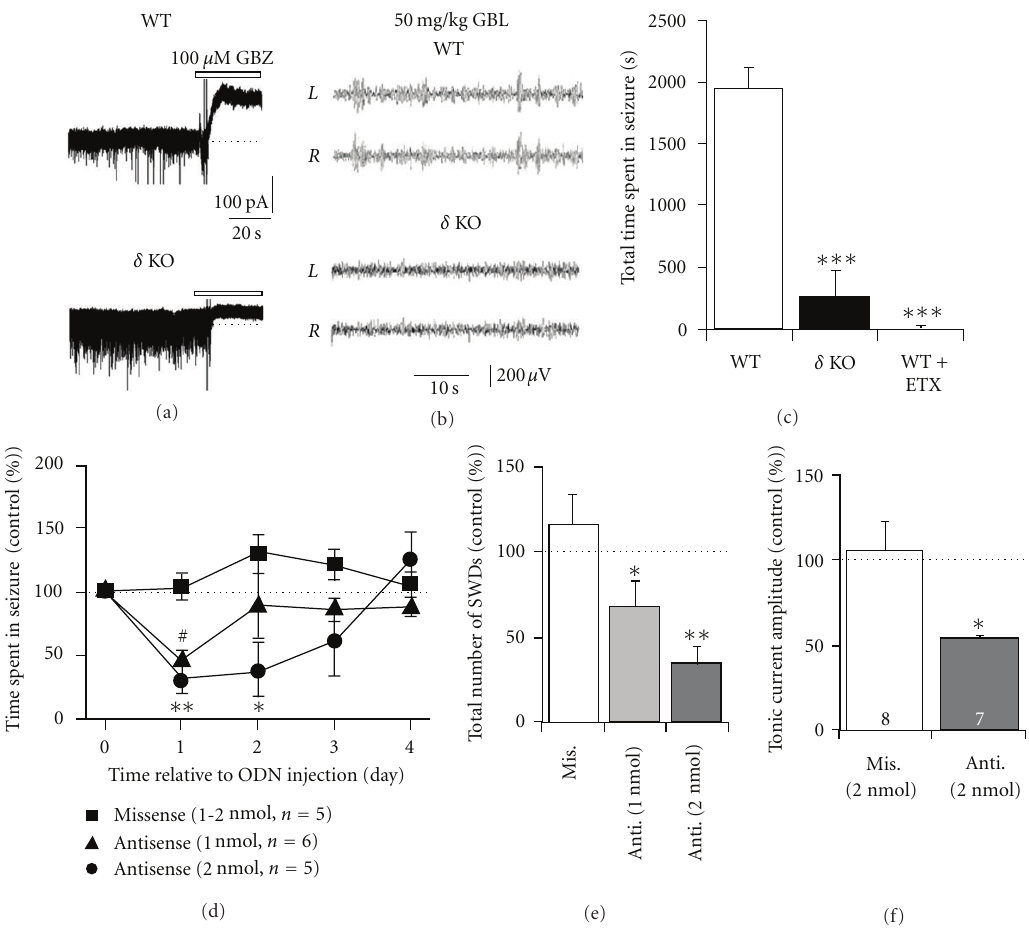
Figure 5: δ subunit containing eGABA A RS in thalamocortical neurons are crucial for expression of SWDs. (a) Tonic GABA A currents are nearly completely ablated in VB TC neurons from δ − / − mice. In comparison, WT mice display robust tonic currents as revealed by focal application of GBZ to the recording chamber. (b) Bilateral EEG traces demonstrating that GBL (the GHB prodrug) induces SWDs in WT littermates but not in δ − / − mice. (c) Ethosuximide-sensitive SWDs that are observed in GBL-injected WT mice are significantly reduced in δ − / − mice. Graph summarises the total time spent in seizure. (d) Intrathalamic injection of δ subunit-specific antisense oligodeoxynucleotides (ODN) produced a significant reduction in time spent in seizure in GAERS for two days post injection. In contrast sham injection of a missense ODN had no significant e ff ect on the occurrence of SWDs. (e) Graph summarising the e ff ect of ODN injection into VB thalamus upon seizure number normalized to preinjection control values. (f) Graph summarising the e ff ect of anti- and missense ODN injection into VB thalamus of GAERS animals upon tonic current amplitude measured in vitro. Acute brain slices were prepared 1 day after intrathalamic injections were administered. (a–f) reproduced from [34].